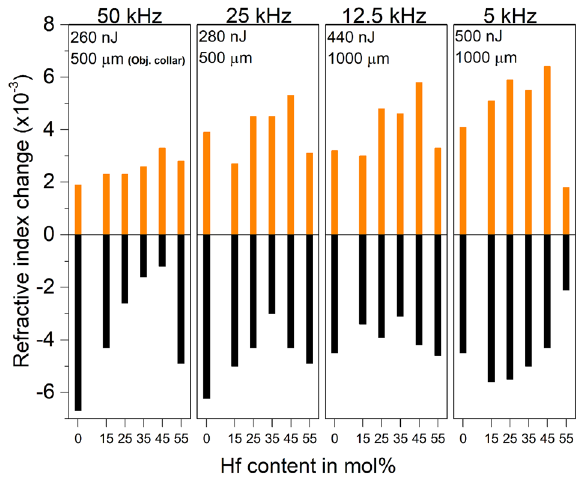
Figure 3. Evolution of refractive index as a function of HF content for four different repetition rates. Laser energy and focussing objective collar was adjusted to achieve maximum index change. Feed rate was kept constant at 0.04 mm/s.